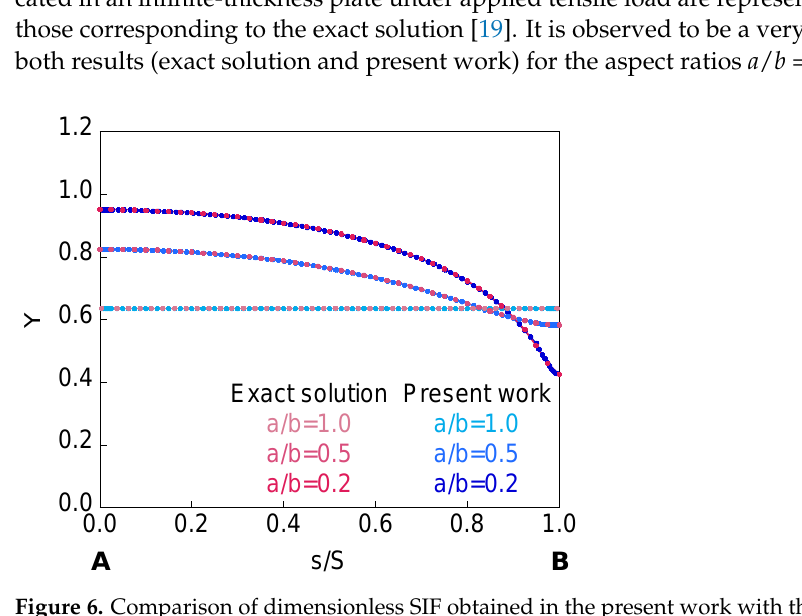
Figure 6. Comparison of dimensionless SIF obtained in the present work with the exact solution for an embedded crack in an infinite-thickness plate.